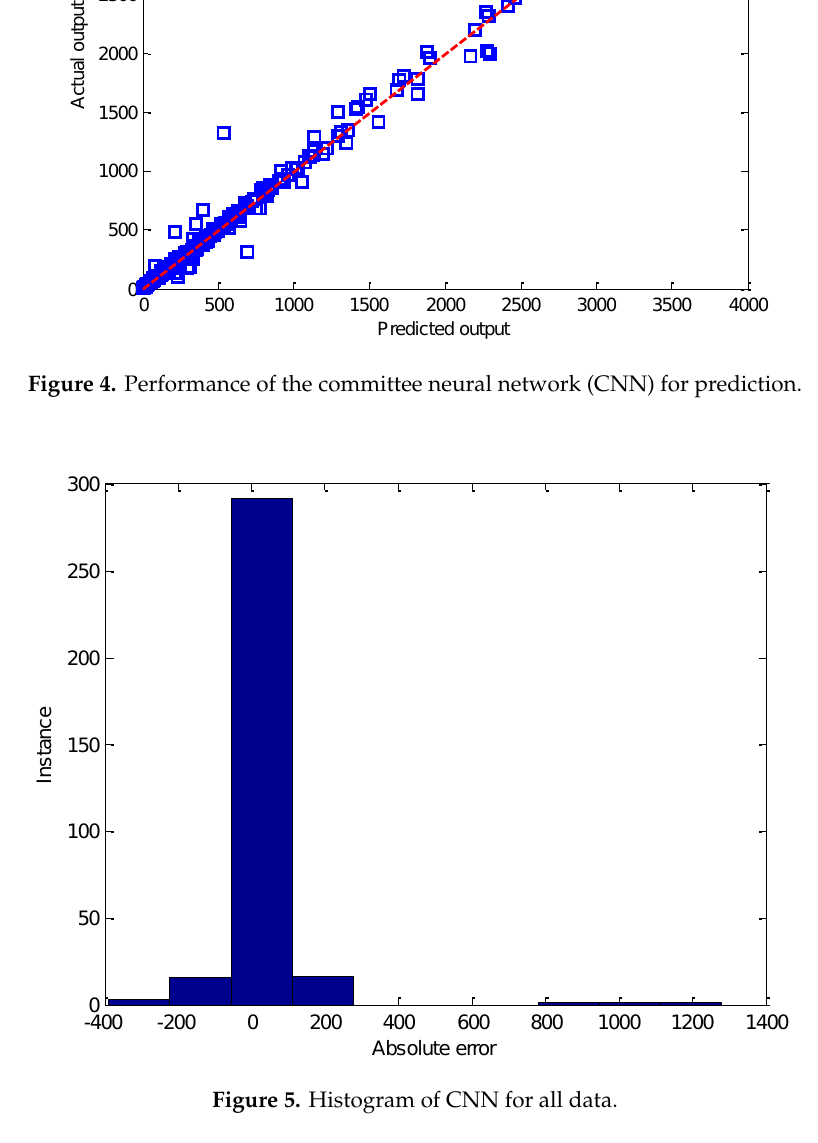
Figure 5. Histogram of CNN for all data .